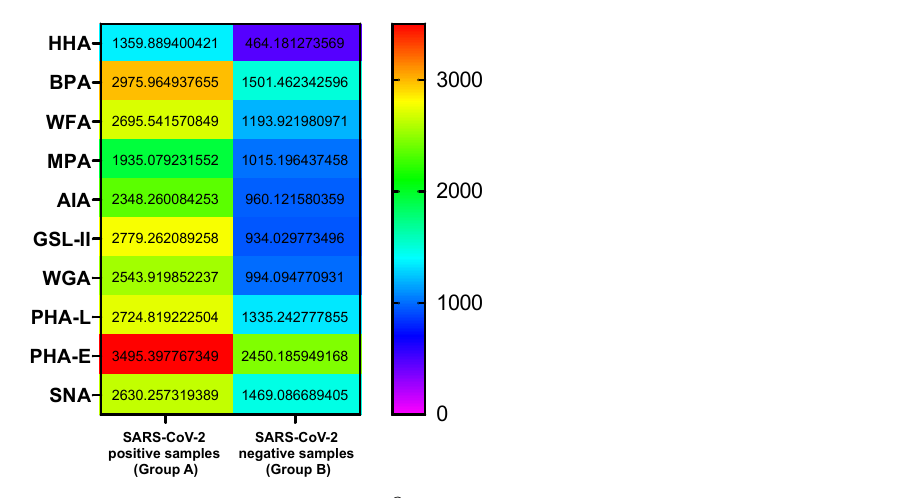
Figure 4. Average of GLYcoPROFILE ® fluorescence intensities interactions of nasopharyngeal SARS-CoV-2-positive and -negative samples with lectins.